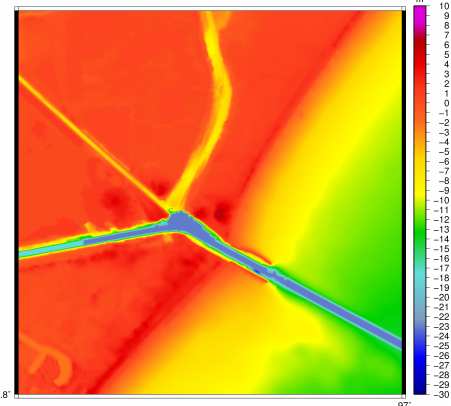
Figure 4. Proposed